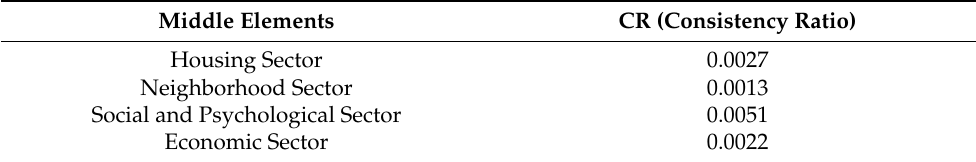
Table 4. The Consistency Ratio of Middle Elements for AHP